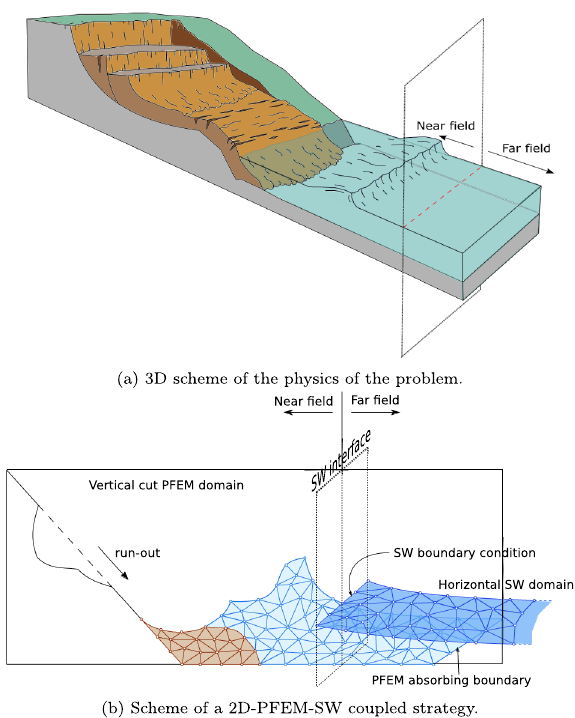
Fig. 2 Schematic view of the near - field solver and the far - field solver for the coupled solution of